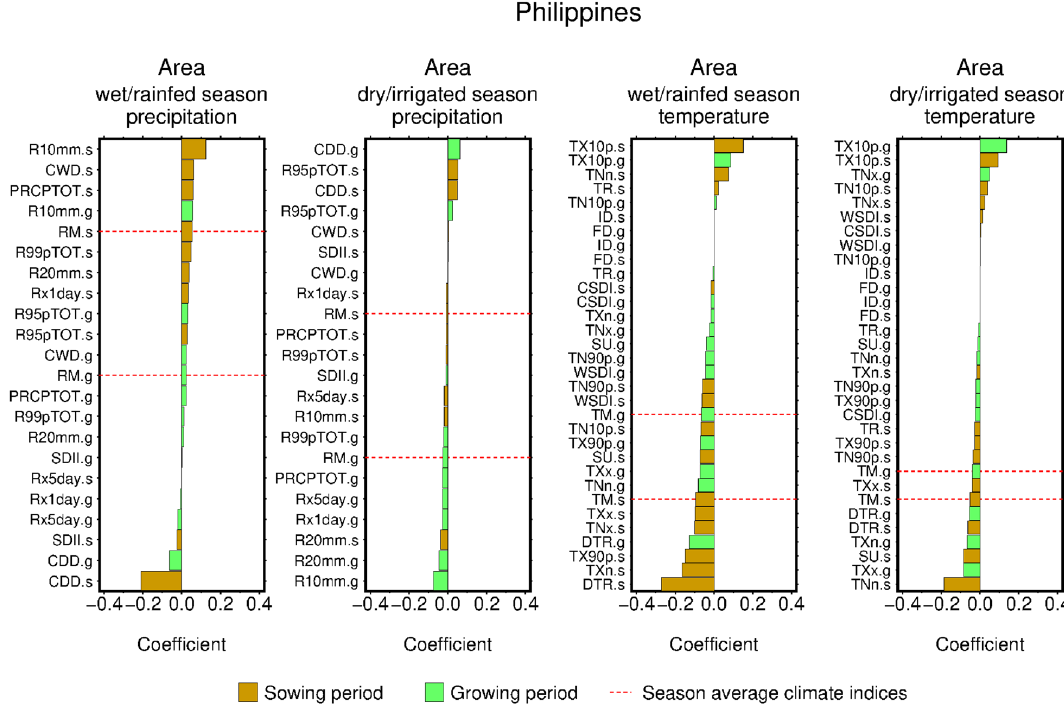
Figure 3. Area response to climate in the Philippines. The values indicate the standardized average regression coefficients of the elastic net regression models. The predictors with and without red dotted lines denote average and extreme climate indices, respectively. Brown indicates the sowing period; Green indicates the average of early and late growing period groups. The four panels show the different seasons (wet/rainfed and dry/irrigated) and climate variables (precipitation and